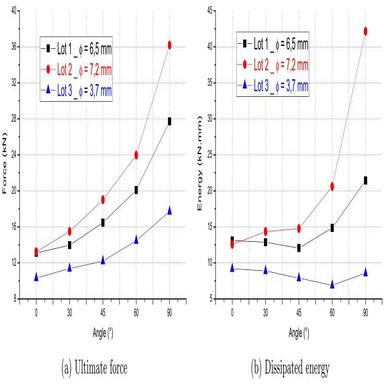
Effect of the nugget spot weld diameter on the (a) ultimate force and (b) dissipated energy.